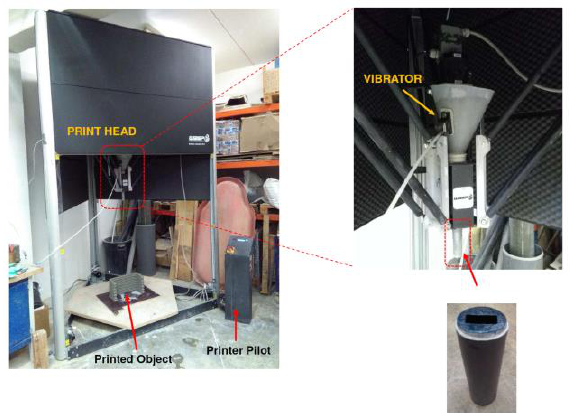
Figure 2. Picture of the printing system: printer, printing head and nozzle.